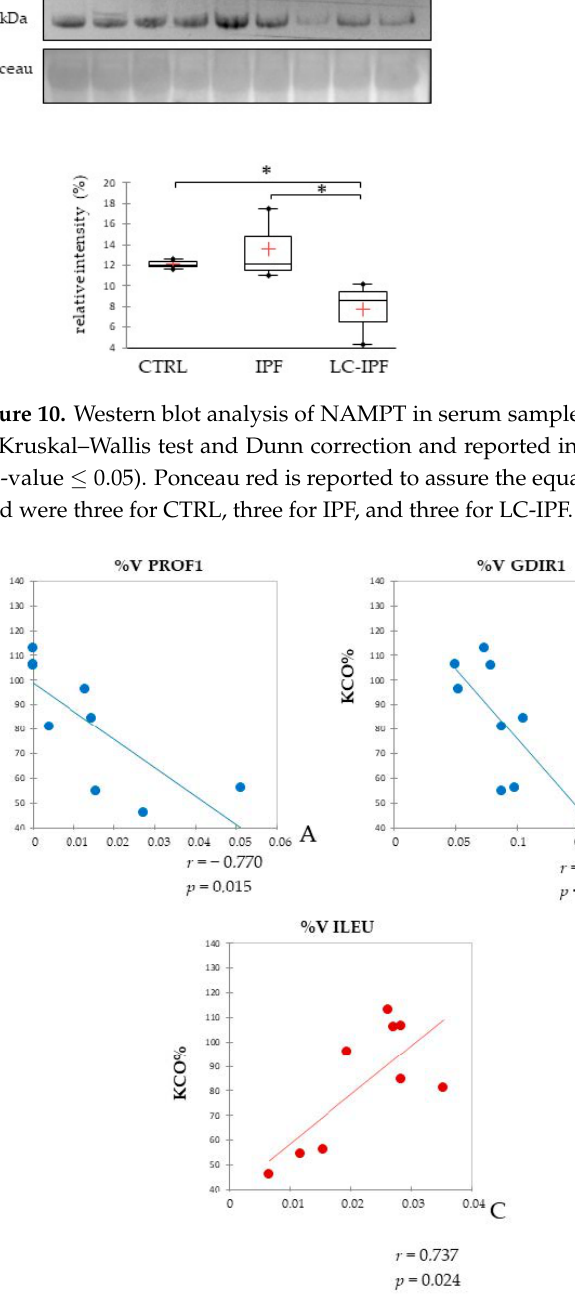
Figure 11. Pearson’s Correlation. Pearson’s correlation between KCO% in IPF and LC-IPF patients and PROF1 %V ( A ), GDIR1 %V ( B ), and ILEU %V ( C ) in BALF samples. Pearson’s correlation coefficients (r) and p-values (p) are shown for each plot.